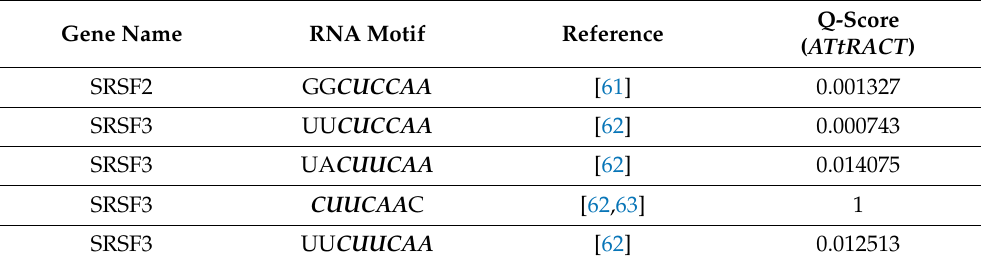
Table 3. Experimentally validated interactions between RBPs and RNA motifs CUUCAA and CUC- CAA identified within pre-miR-126 and pre-mir-515-1